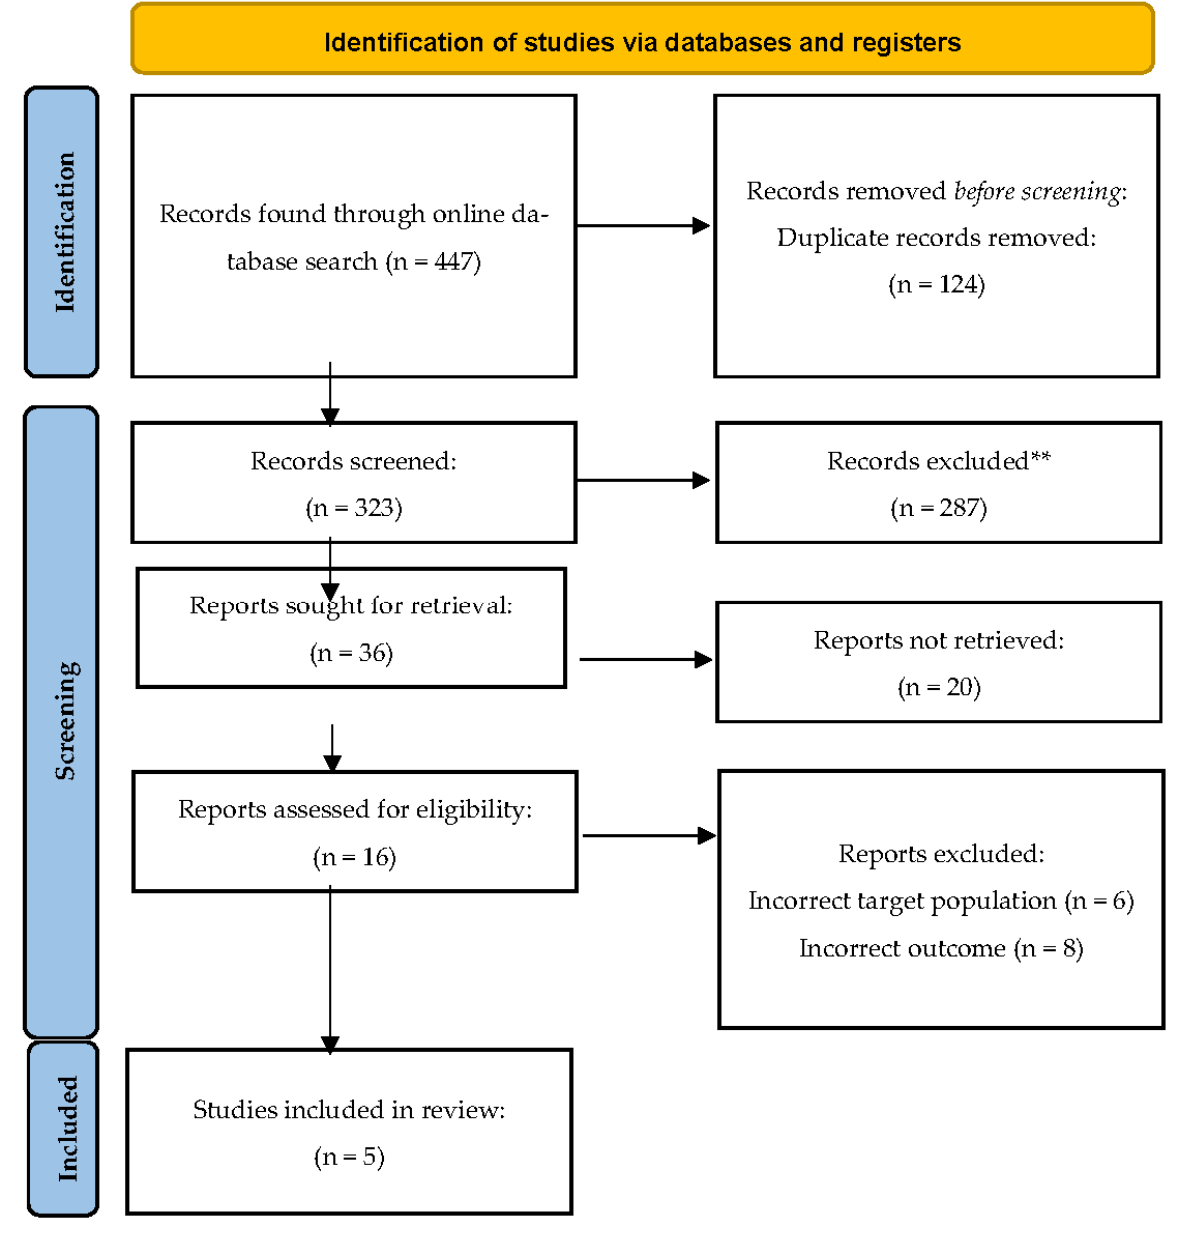
Figure 1. Flow diagram of the literature review.